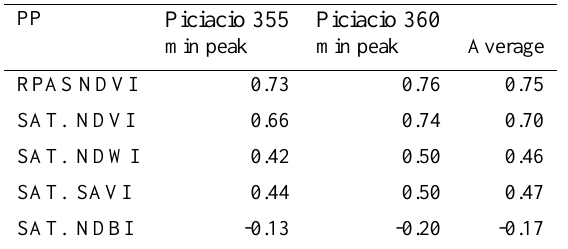
Table 1. Minimum and average values used to set the PP threshold.